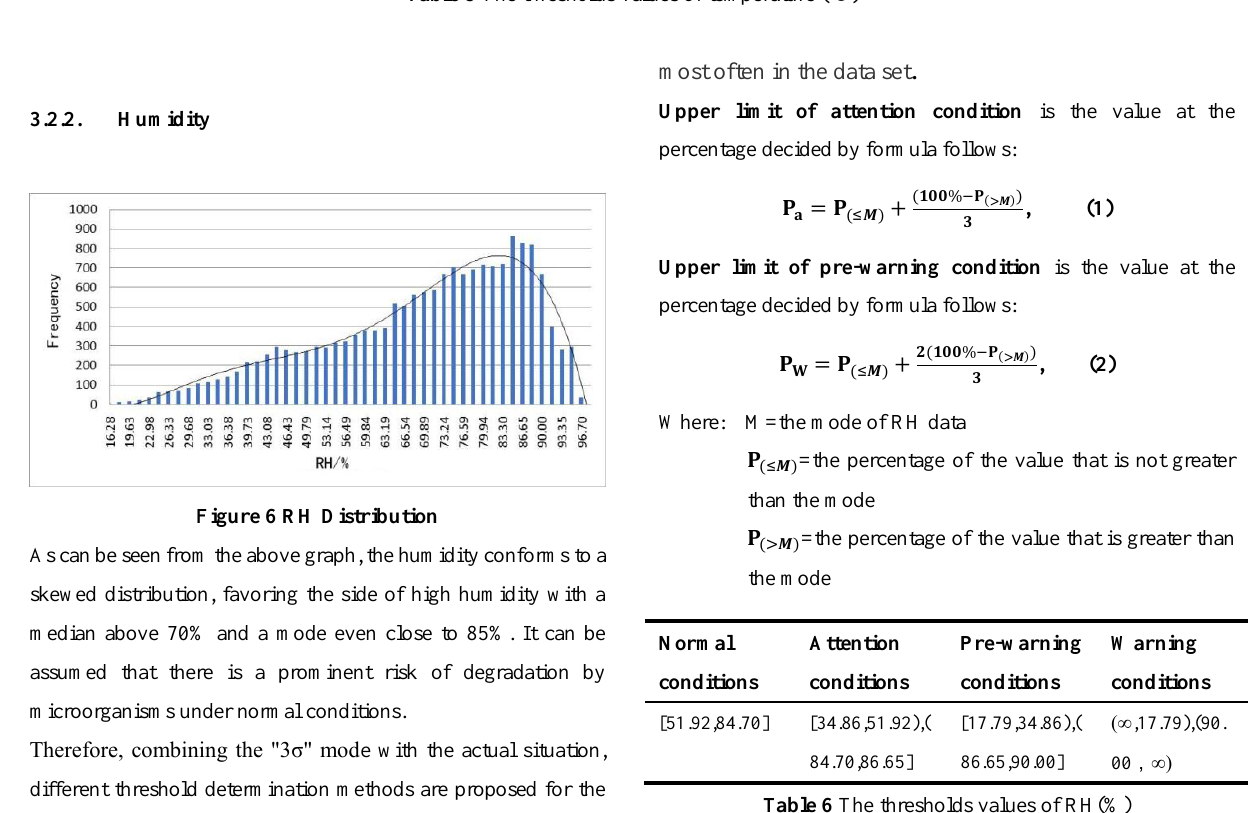
Table 5 The thresholds values of temperature ( ℃ )